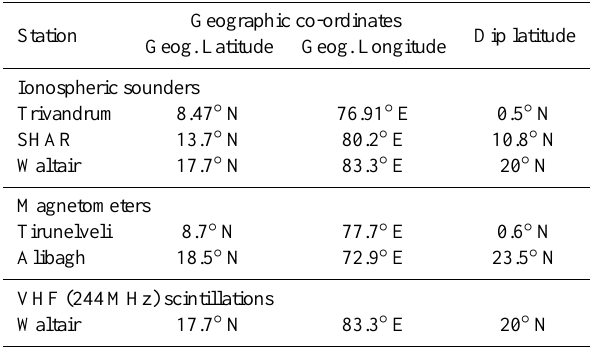
Table 1. Geographical locations of the different instruments oper- ated during the period of study.